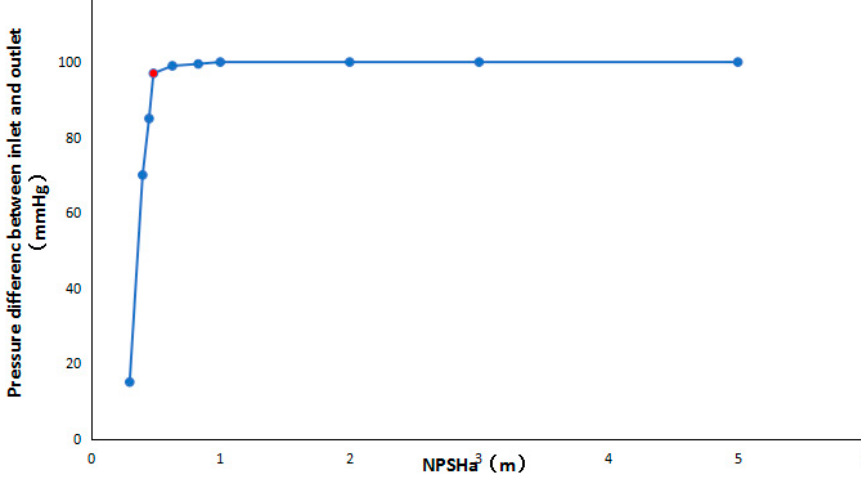
Figure 9. Cavitation characteristics of the centrifugal blood pump.